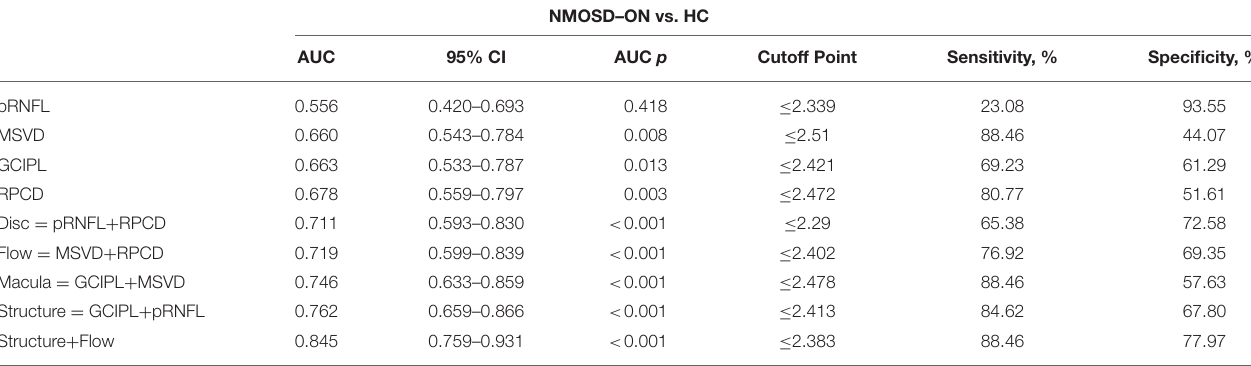
TABLE 3 | Diagnostic accuracy of OCT and OCT-A parameters.